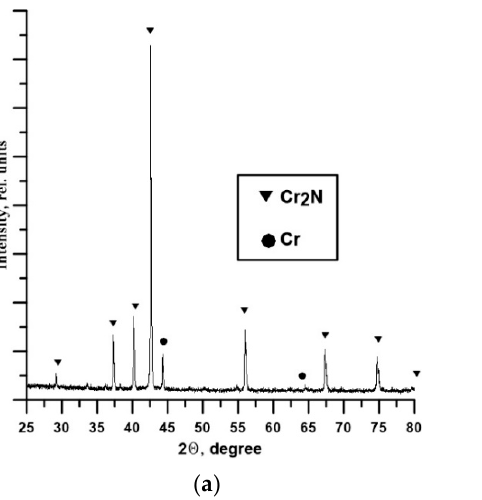
Figure 7. Photographs of synthesized Cr 2 N samples. The microstructure of a Cr 2 N sample, obtained by the combustion of chromium powder in a co- flow of nitrogen–argon mixture ( q = 12 cm 3 /(s·cm 2 ); [Ar] = 7%), in comparison with the microstructure of a Cr 2 N powder obtained under natural filtration mode at p = 0.2 MPa (the method is described in [26]), is presented in Figure 8.